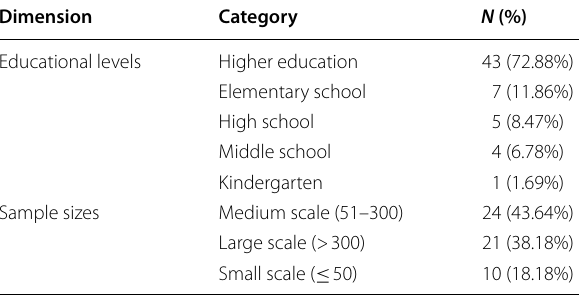
59) and sample sizes ( N =